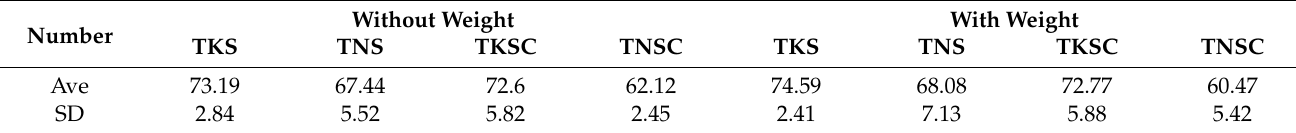
Table 4. The segmentation performance for the proposed algorithm in four